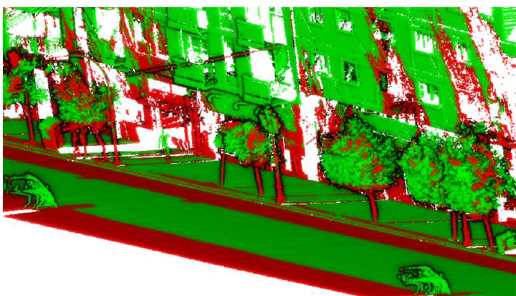
Figure 13: Point cloud coloured by correct semantic segmentation for 11 classes, 500 hidden layers and weighted. Correct segmented classified point in green and misclassified in